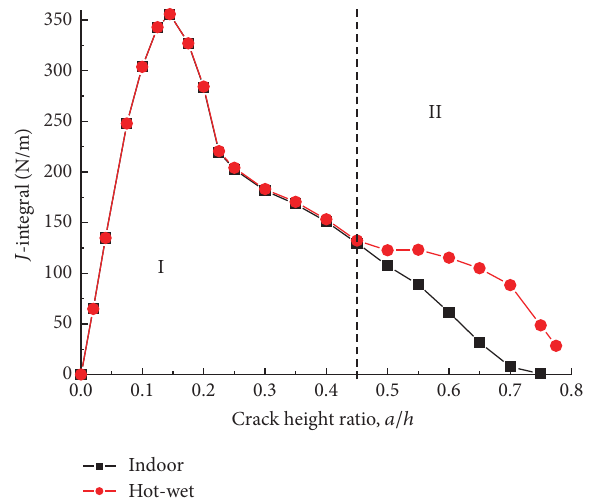
Figure 8: Effect of environment on 𝐽 -